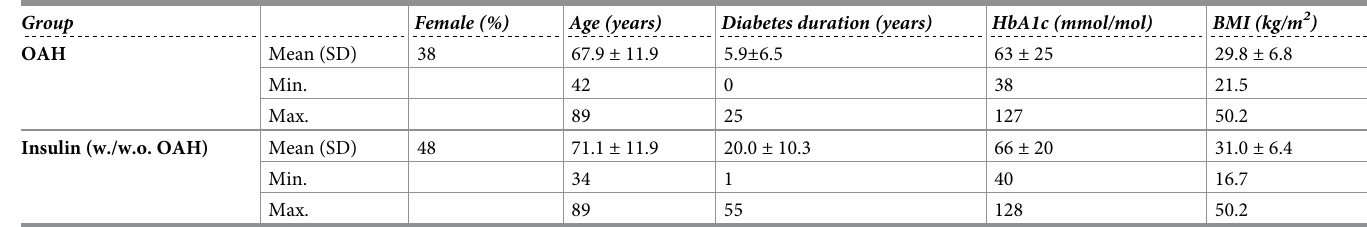
Table 1. Baseline